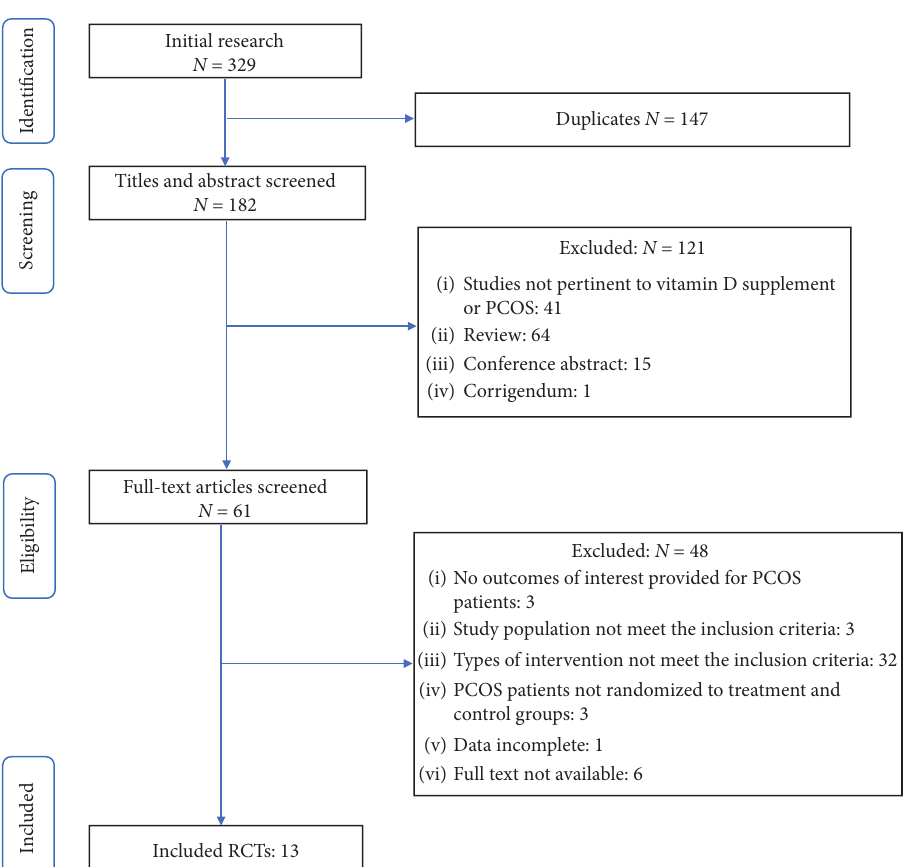
Figure 1: Flowchart of search Figure 6(b)), HDL-C (SMD: 0.15, 95% CI: − 0.03, 0.33; Figure 6(d)), or triglycerides (SMD: − 0.23, 95% CI: − 0.50,